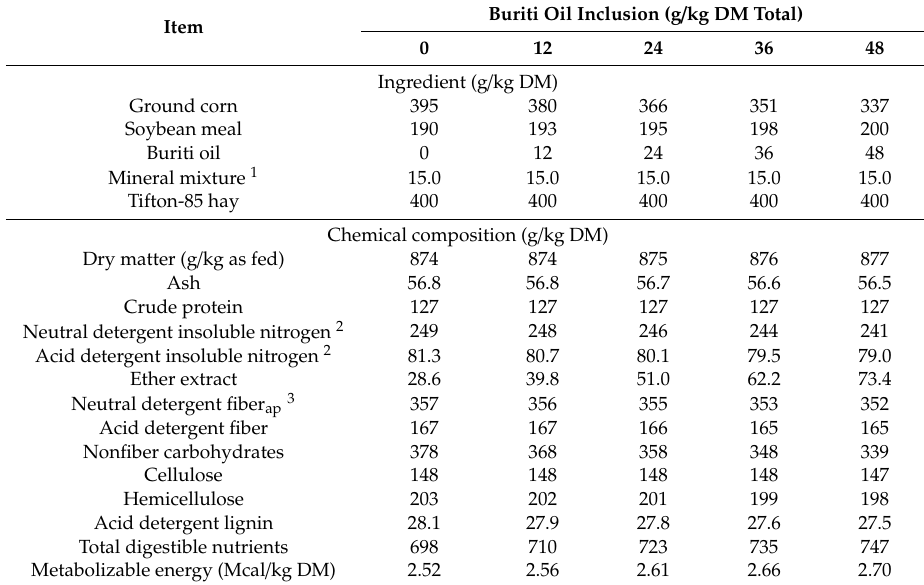
Table 2. Ingredient proportion and chemical compositions of experimental lamb diets with incremental quantities of buriti